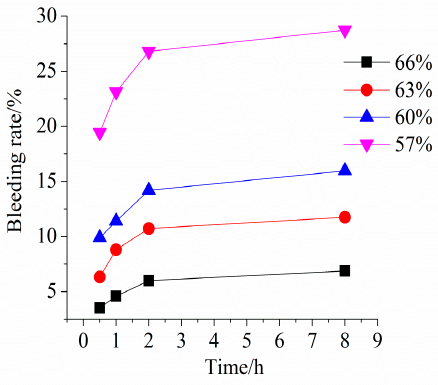
Figure 2. Effect of solids concentration on the bleeding rate of slurry.